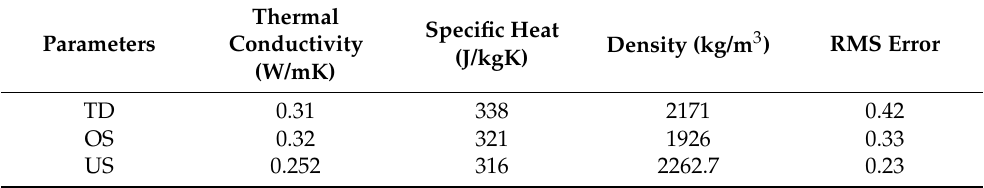
Table 3. Thermal and physical properties of TD, OS and US lots.